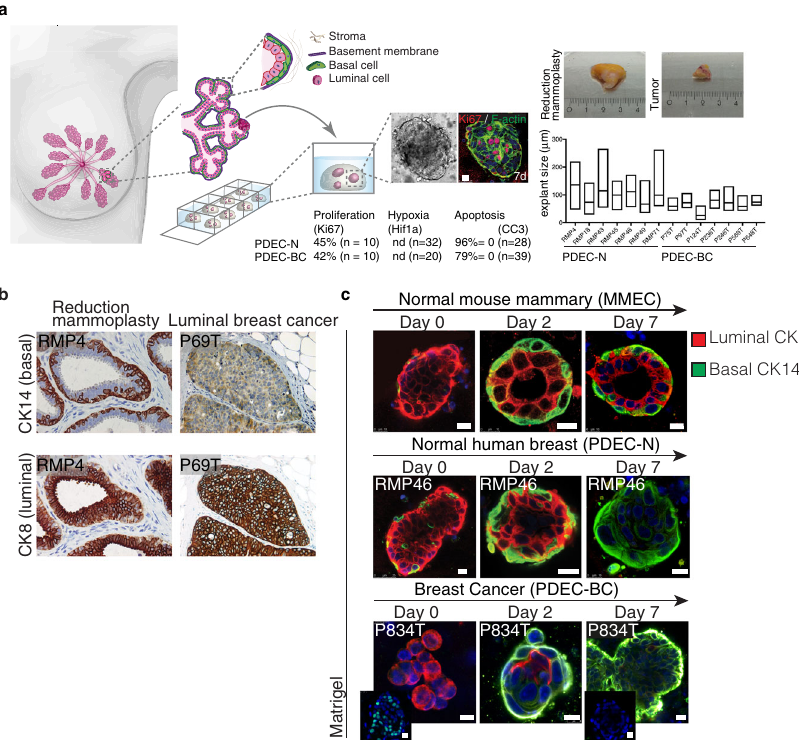
Fig. 1 Patient-derived explant culture (PDEC) model for normal breast and breast cancer tissues. a Schematic representation of the breast epithelial tissue (PDEC-N) and breast cancer (PDEC-BC) culture system. The table shows level of proliferation, hypoxia and viability and the bar graph shows the average explant size and the size distribution. More details of the analysis of the culture system in Supplementary Fig. 1. (nd = not detected) b Immunohistochemistry staining of cytokeratins 8 (CK8) and 14 (CK14) in reduction mammoplasty and luminal breast cancer samples. RMP4 refers to reduction mammoplasty corresponding to the patient number. Similarly, P69T refers to tumor sample from patient 69. N = 10 biologically independent samples. c Immuno fl uorescence images of MMECs, PDEC-N and PDEC-BC stained for CK8 and CK14 after 0, 2, and 7 days of culture in Matrigel. Day 0 samples were fi xed immediately after embedding the samples in the matrix. Day 2 and day 7 indicate the culture time before fi xation. Insets show immuno fl uorescent staining of ER α + in the original tumor and the corresponding PDEC-BC explants, cultured in Matrigel for 7 days. N = 6 (MMEC, PDEC- N) and N = 3 (PDEC-BC) explants examined from three biologically independent samples. Scale bars = 10 μ